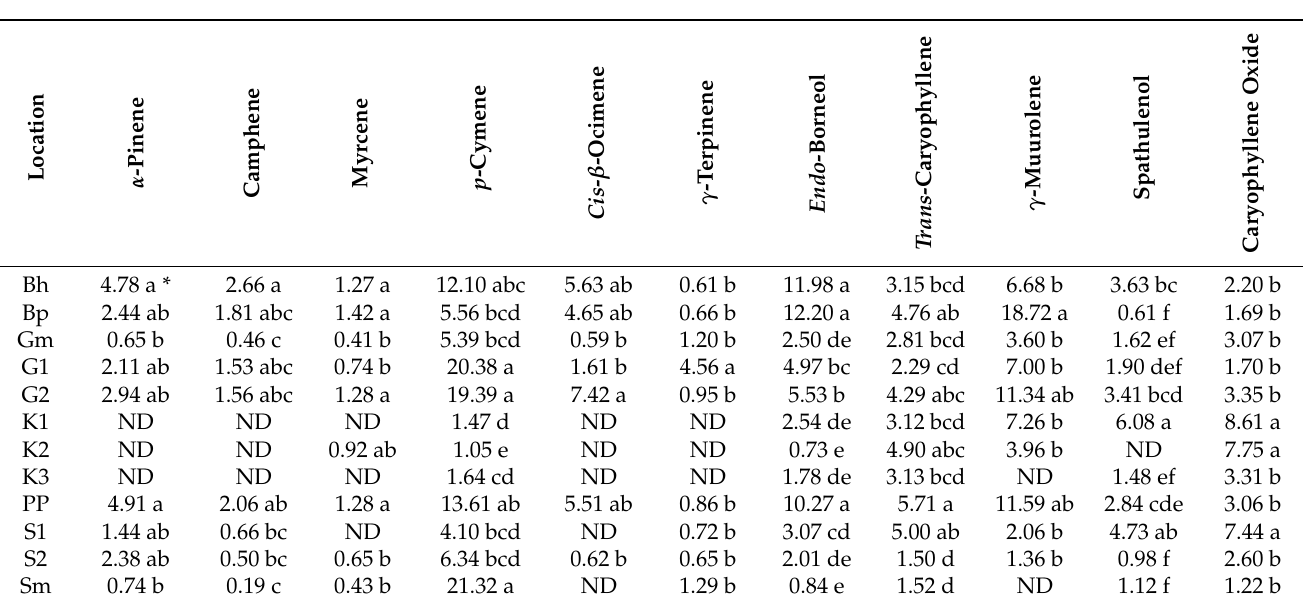
Table 9. Mean concentration (%) of α -pinene, camphene, myrcene, p -cymene, cis - β -ocimene, γ - terpinene, endo -borneol, trans -caryophyllene, γ -muurolene, spathulenol, and caryophyllene oxide of S. kitaibelii collected at 11 locations and S. montana (cultivated).